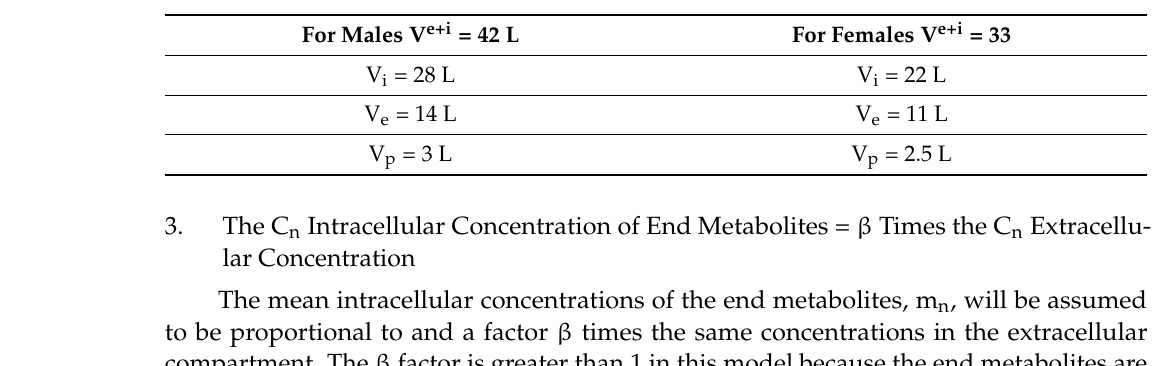
Table 2. Total Male and Female Intracellular, Extracellular, and Plasma